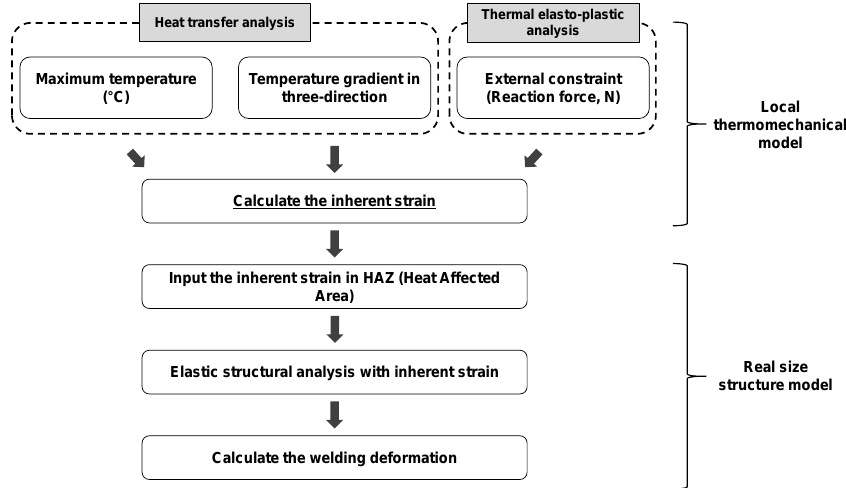
Figure 7. Calculation flow chart for welding deformation using inherent strain.